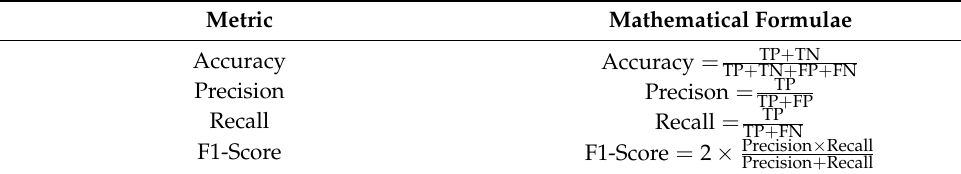
Table 4. Evaluation